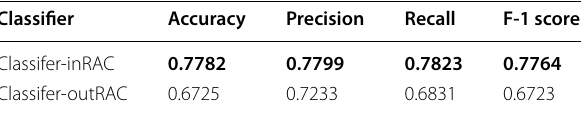
Table 5 Scores of evaluation metrics obtained by Classifer- inRAC on the testing samples in datasets D1, D2, and D3 Dataset